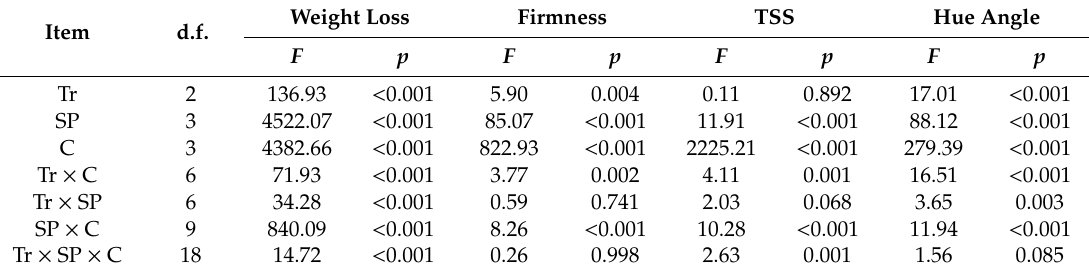
Figure 2. Changes in weight loss of four tomato cultivars over 15 days of storage under IS (immediate storage), DS (storage delayed 24 h), and DSC (storage delayed 24 h under cover) postharvest treatments. Table 3. Three-way ANOVA showing individual and interaction effect of the postharvest treatment (Tr), cultivar (C), and storage period (SP) on weight loss, firmness, total soluble solids (TSS), and hue angle of tomatoes.